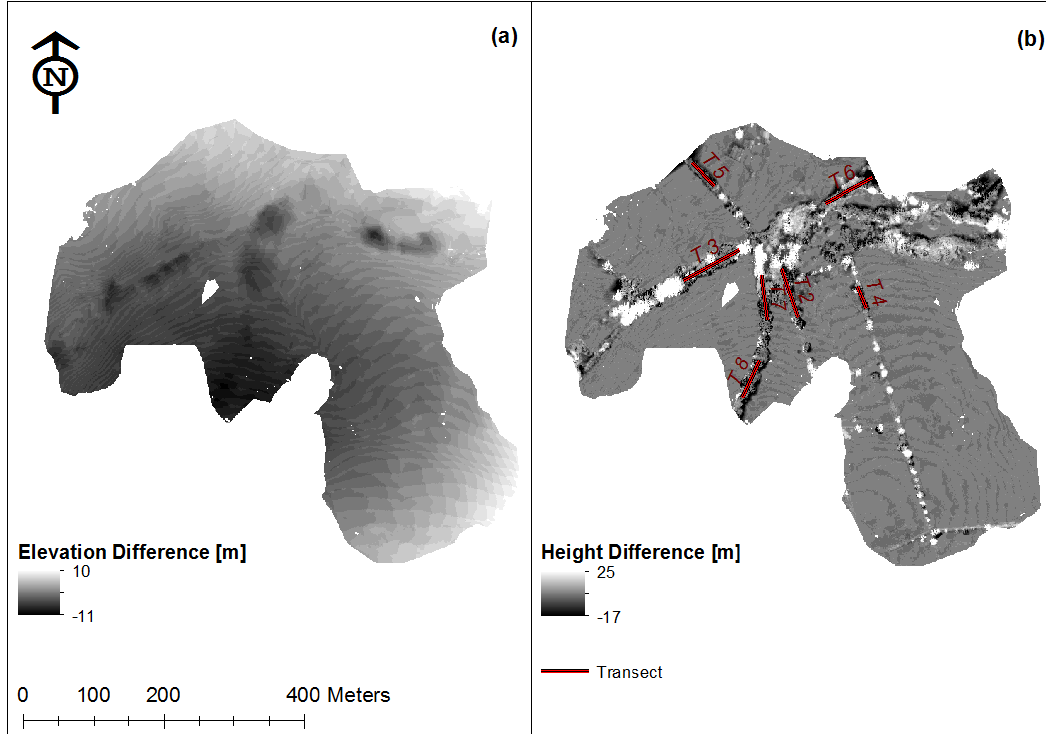
Figure 9. Showing for the Meshaw site; ( a ) DEM difference map and ( b ) CHM difference map generated by subtracting the SfM DEM from the LiDAR DEM and the SfM CHM from the LiDAR CHM, respectively. Canopy height profiles were extracted from the 7 transects shown in red.